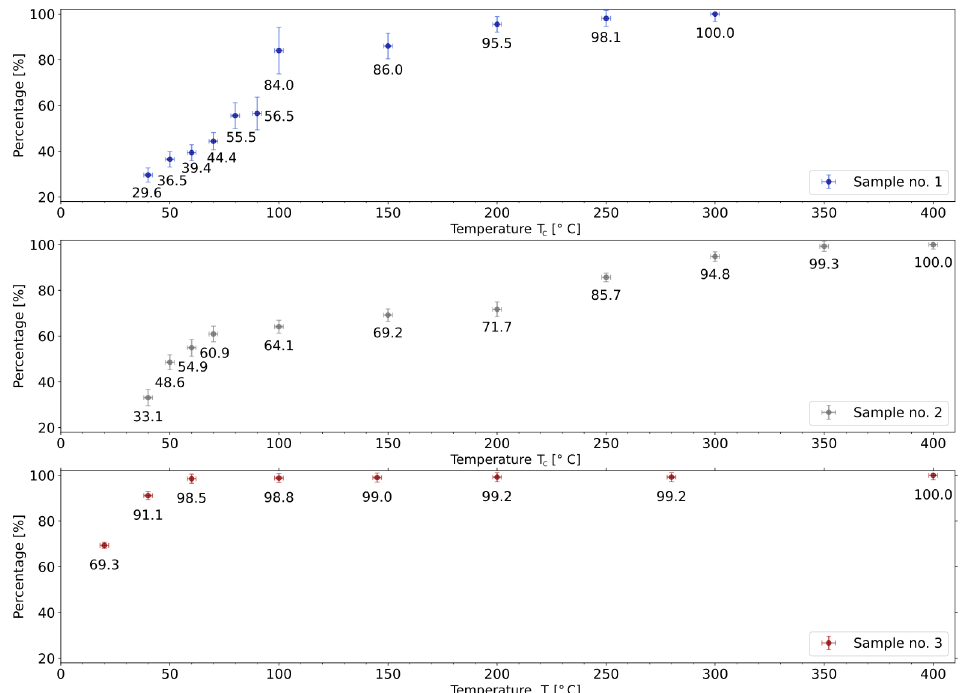
Figure 8. Percentage of 131m Xe activity collected up until temperature T c normalized to the total collected 131m Xe